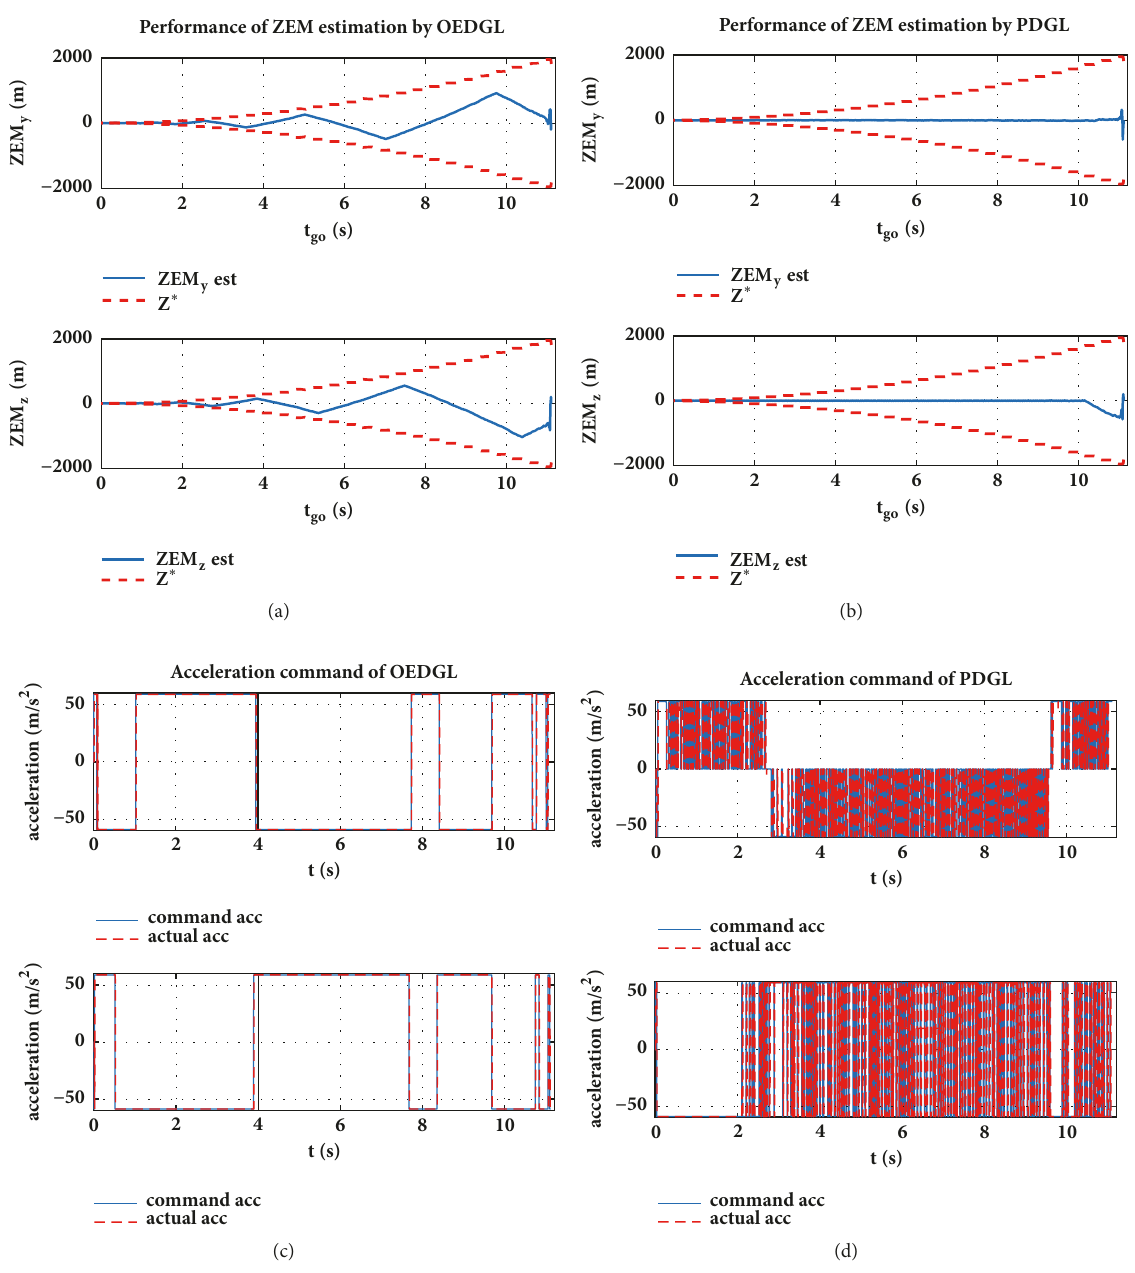
Figure 4: The performance comparison of ZEM estimation and guidance command between OEDGL and PDGL.